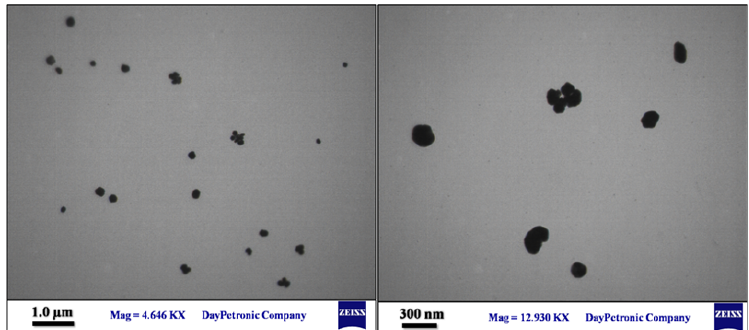
Figure 3. TEM images and respective size distribution M. piperita